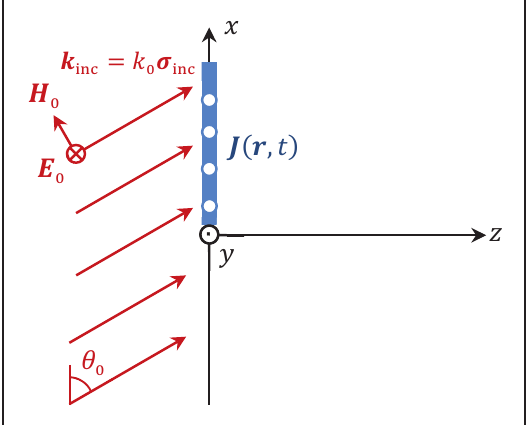
Fig.5 . A plane, monochromatic EM wave propagating along the unit-vector (cid:2252) arrives at a thin, semi-infinite, perfectly electrically conducting screen located in the upper half of the (cid:1876)(cid:1877) - plane. The plane-wave is linearly polarized, with its (cid:1831) -field aligned with the (cid:1877) -axis, while its (cid:1834) -field has components along the (cid:1876) and (cid:1878) directions. The induced current sheet, denoted by (cid:2166) ( (cid:2200) , (cid:1872) ) , oscillates parallel to the incident (cid:1831) -field along the direction of the (cid:1877) -axis. (The system depicted here is essentially the